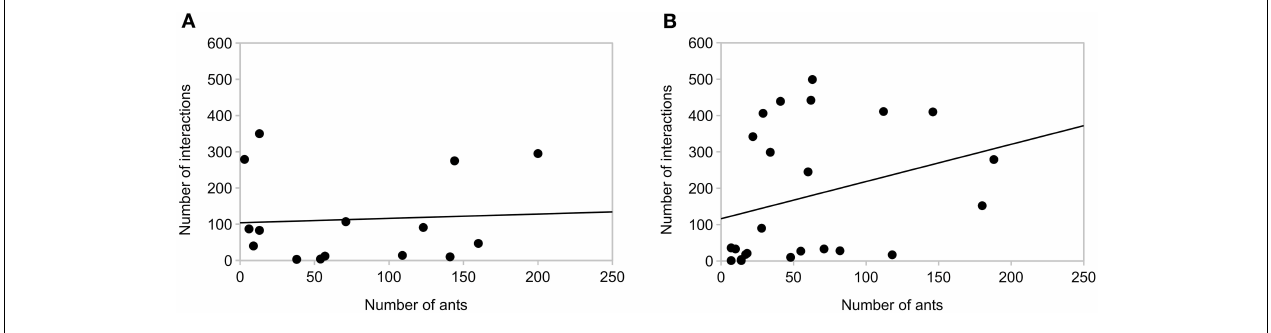
FIGURE 7 | Relation of number of interactions and number of ants. (A) Earth (B) Space. Each point shows the number of interactions and the number of trajectories that entered one area: Area 1 closed, for 5min before the barrier was opened, Area 1 open, for